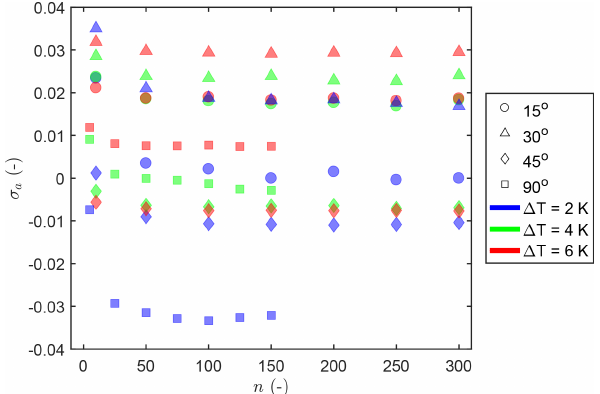
Figure 5. Precision of the AHFO wind speed measurements as a function of averaging period, with n varying from 5 to